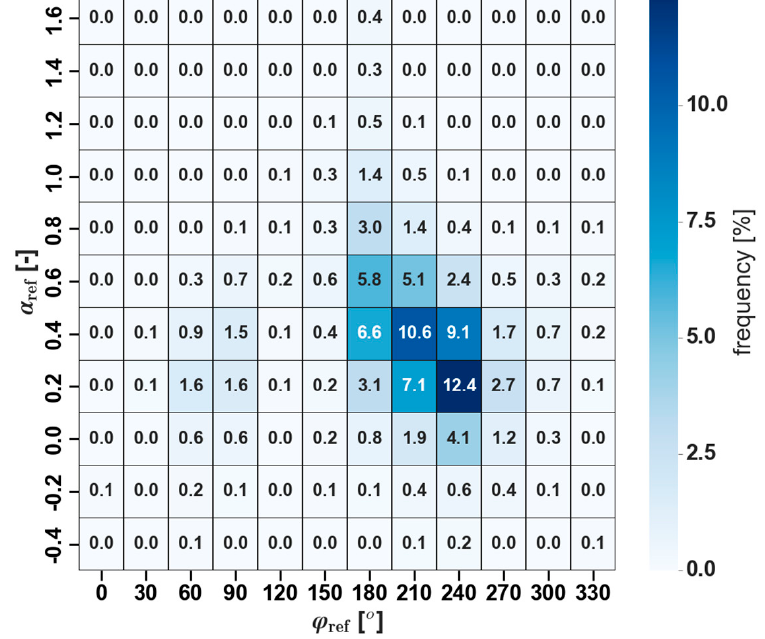
Figure 4. Capture matrix of concurrent scanning lidar and reference sodar measurements binned by wind direction ( ϕ ref ) and shear exponent ( α ref ) as derived from the sodar data. Numbers and colors give the percentage of 30 min samples within the respective bin. The total number of samples is 8872.